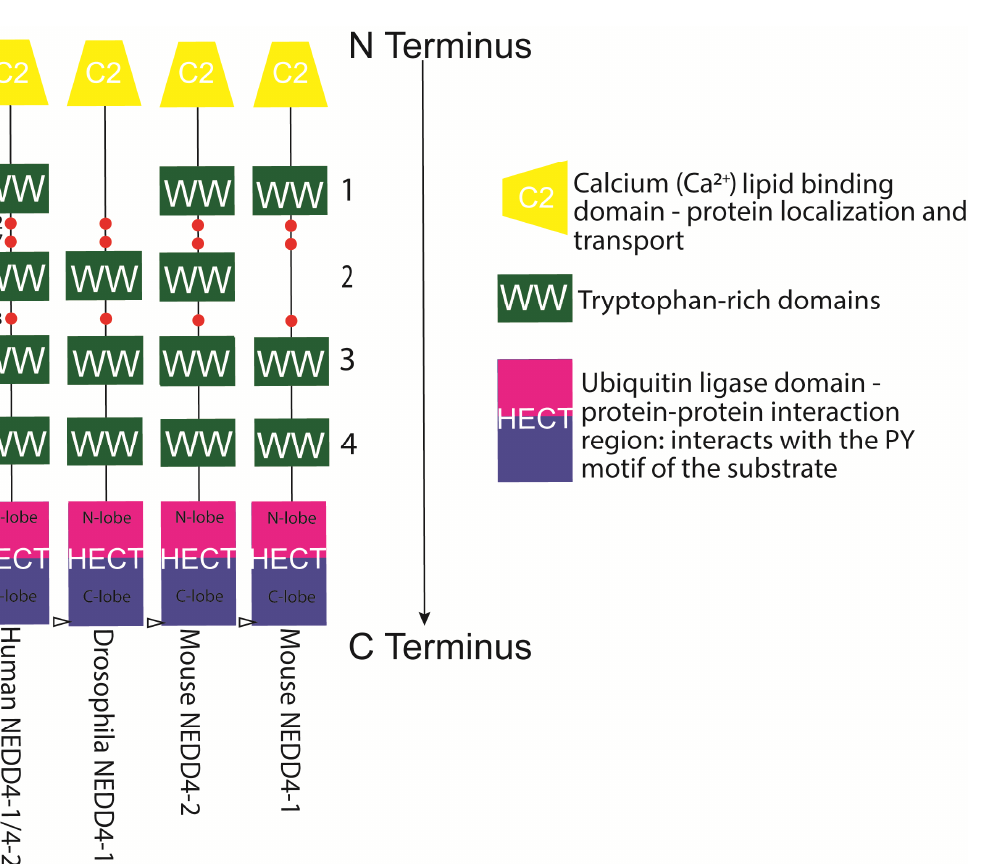
K27 linkage [111]. NEDD4-2 can also mono- and polyubiquitinate its substrate